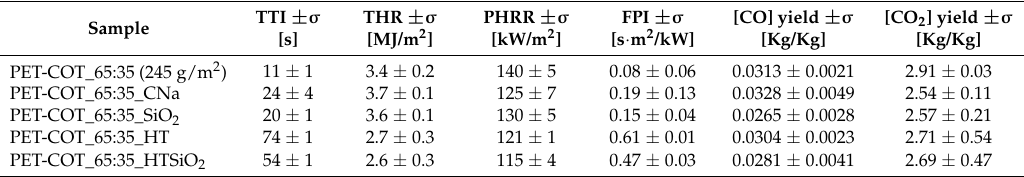
Table 6. Combustion data of untreated and NP-treated PET-COT_65:35 by cone calorimetry (35 kW/m 2 ) [22].